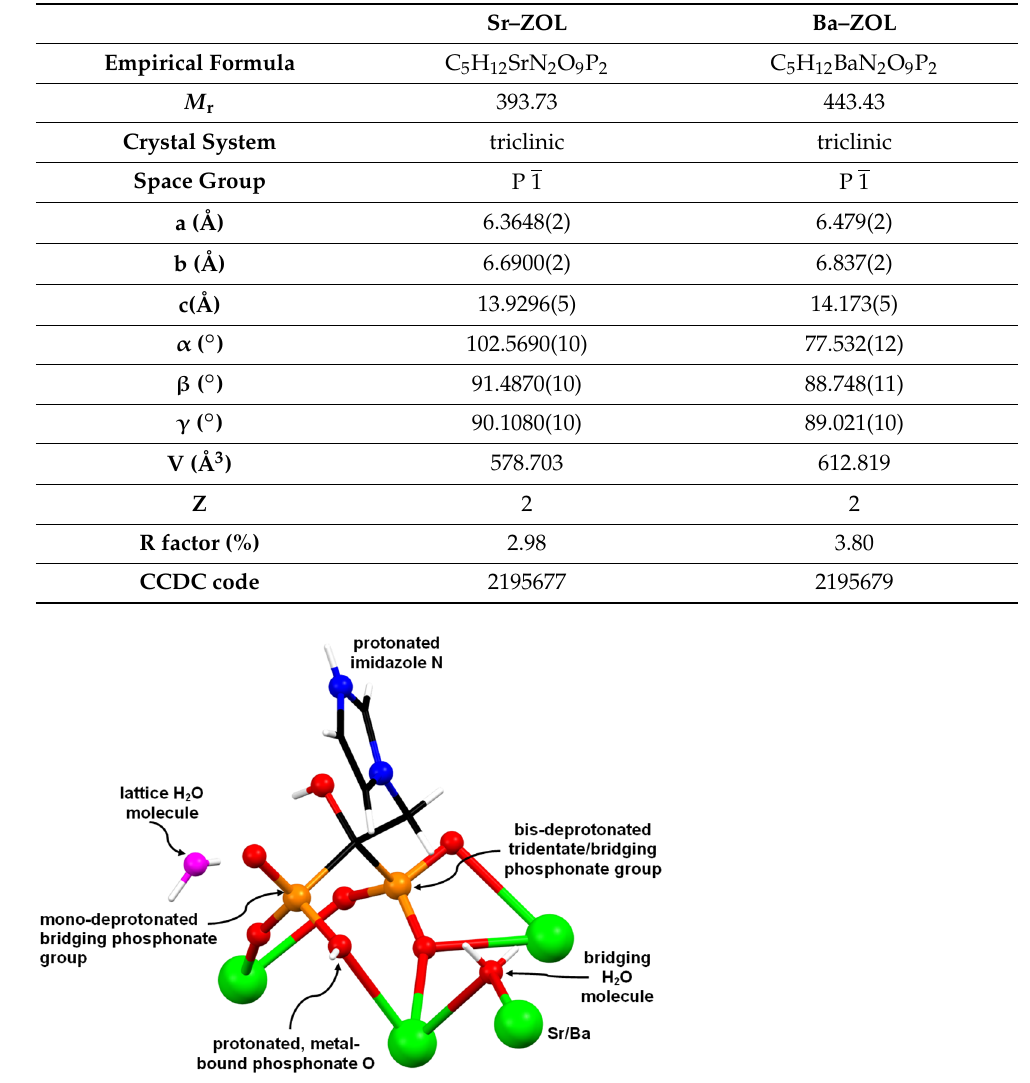
Table 1. Crystal data for compounds Sr–ZOL and Ba–ZOL.